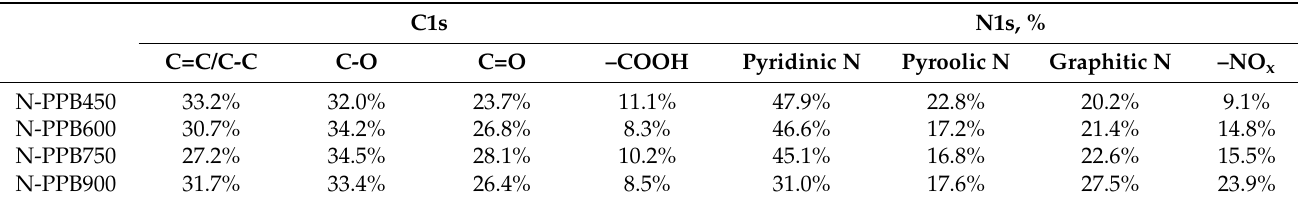
Table 2. Bonding ratio of N-PPB samples based on deconvoluted C1s and N1s XPS peak.